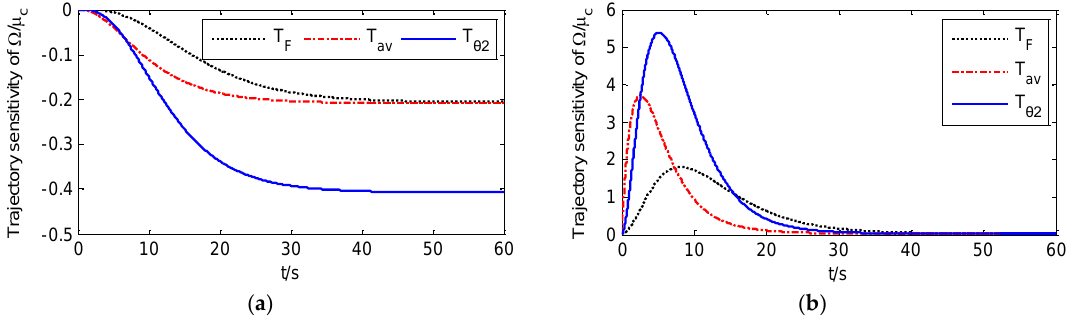
Figure 12. Sensitivity of parameter change to the output variables under two different cases. ( a ) Sensitivity analysis of Ω / μ c under input change of N r ; and ( b ) sensitivity analysis of Ω / μ c under input change of T θ 1